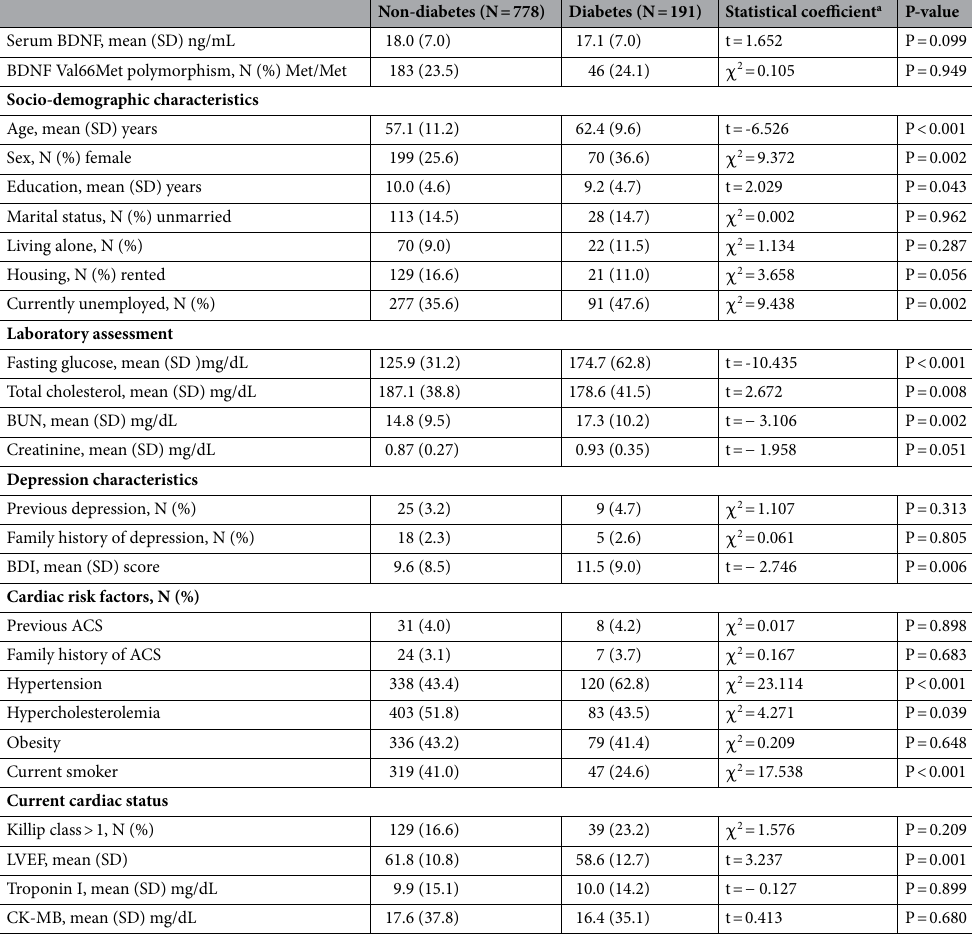
Table 1. Comparisons of baseline characteristics according to diabetes presence in patients with acute coronary syndrome. a Independent two-sample t-test or χ 2 test, as appropriate. BDNF, brain-derived neurotrophic factor; BUN, blood urea nitrogen; BDI, Beck Depression Inventory; ACS, acute coronary syndrome; LVEF, left ventricular ejection fraction; CK-MB, creatine kinase-MB. Diabetes was defined as a diagnosis of diabetes by a doctor or currently administering antidiabetic drugs.